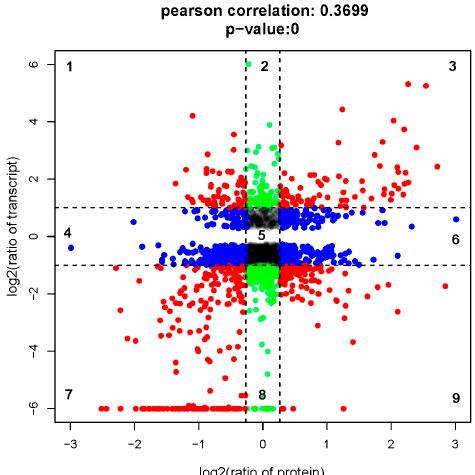
Figure 3. Comparison of expression ratios from transcriptomic ( y -axis) and proteomic ( x -axis) profiling. Log 2 expression ratios were calculated from competent larvae versus post-larvae. Significant changes in expression are color-coded: blue , proteins only; green , transcripts only; red , both.